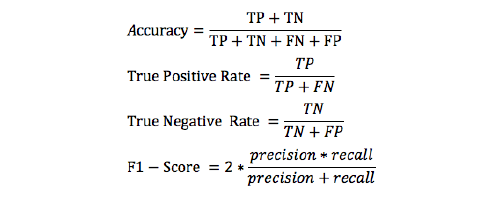
Figure 1. Evaluation